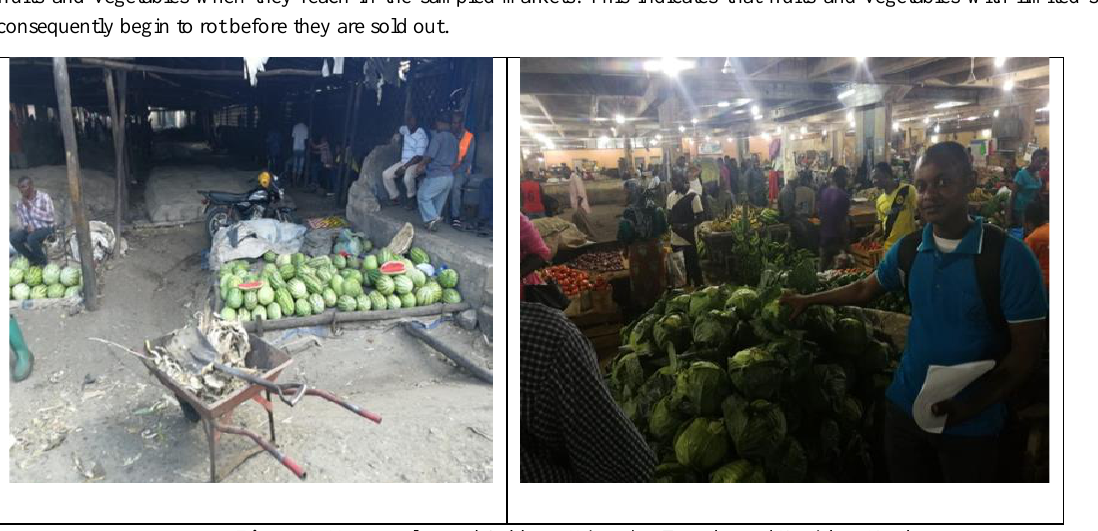
Figure 1: Watermelon and Cabbage Hipped at Temeke and Kariakoo